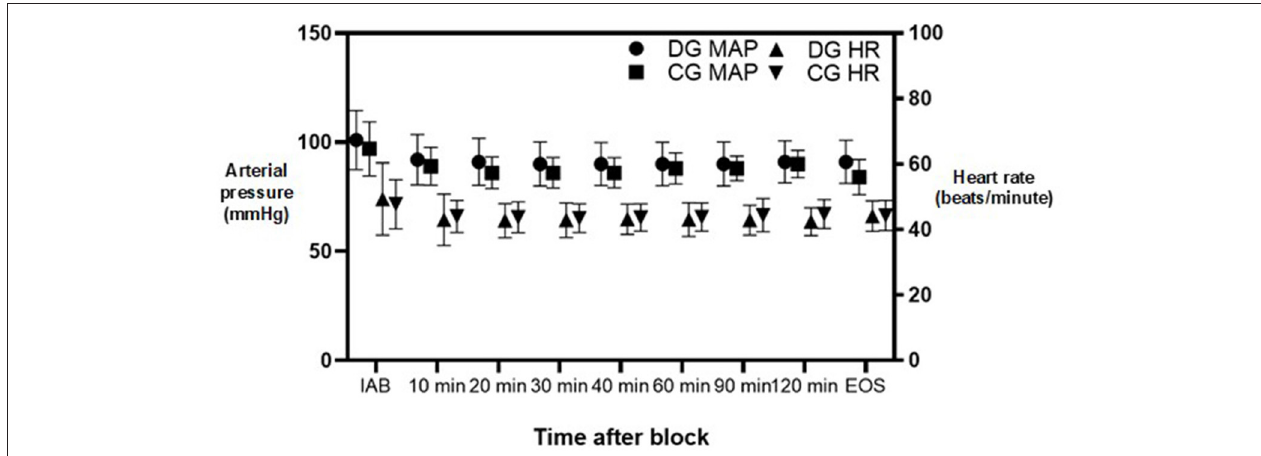
FIGURE 2 | Mean arterial pressure and heart rate changes during surgery. DG, dexmedetomidine group; CG, control group; MAP, mean arterial pressure; HR, heart rate; IAB, initially after block; EOS, end of surgery. Dots represent median values. Lines represent standard deviation.